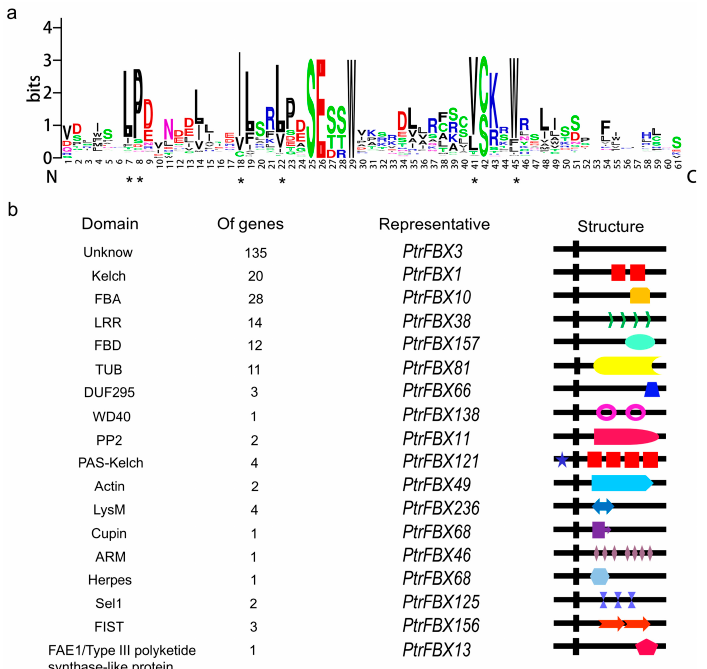
Figure 1. Domain analysis of the F-box proteins in poplar. ( a ) Sequence logo of the conserved F-box domain of the 245 F-box proteins. The x-axis represents the amino acid residues positions in the F- box domain. The y-axis represents the number of times that the amino acid appears in a particular position. The height of a single letter represents the relative frequency of the corresponding amino acid at that position . * represents the conserved amino acid residues of F-box domain. ( b ) The con- served domain names represent on the left, gene numbers and representative gene containing cor- responding domain are in the middle, domain features are on the right. Black vertical box represents a F-box domain, boxes with different colors represent corresponding domains of C terminal.